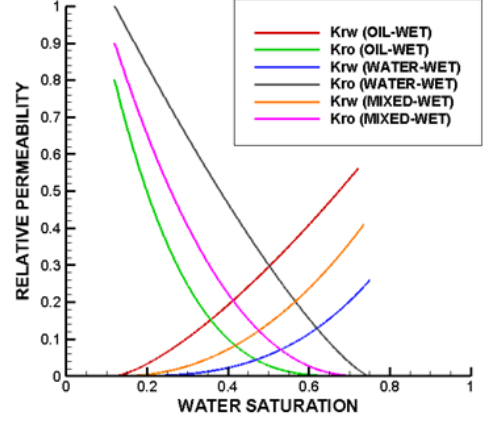
Figure 4: Relative permeability curves for different wettability condi- tions at low trapping number of 10 −7